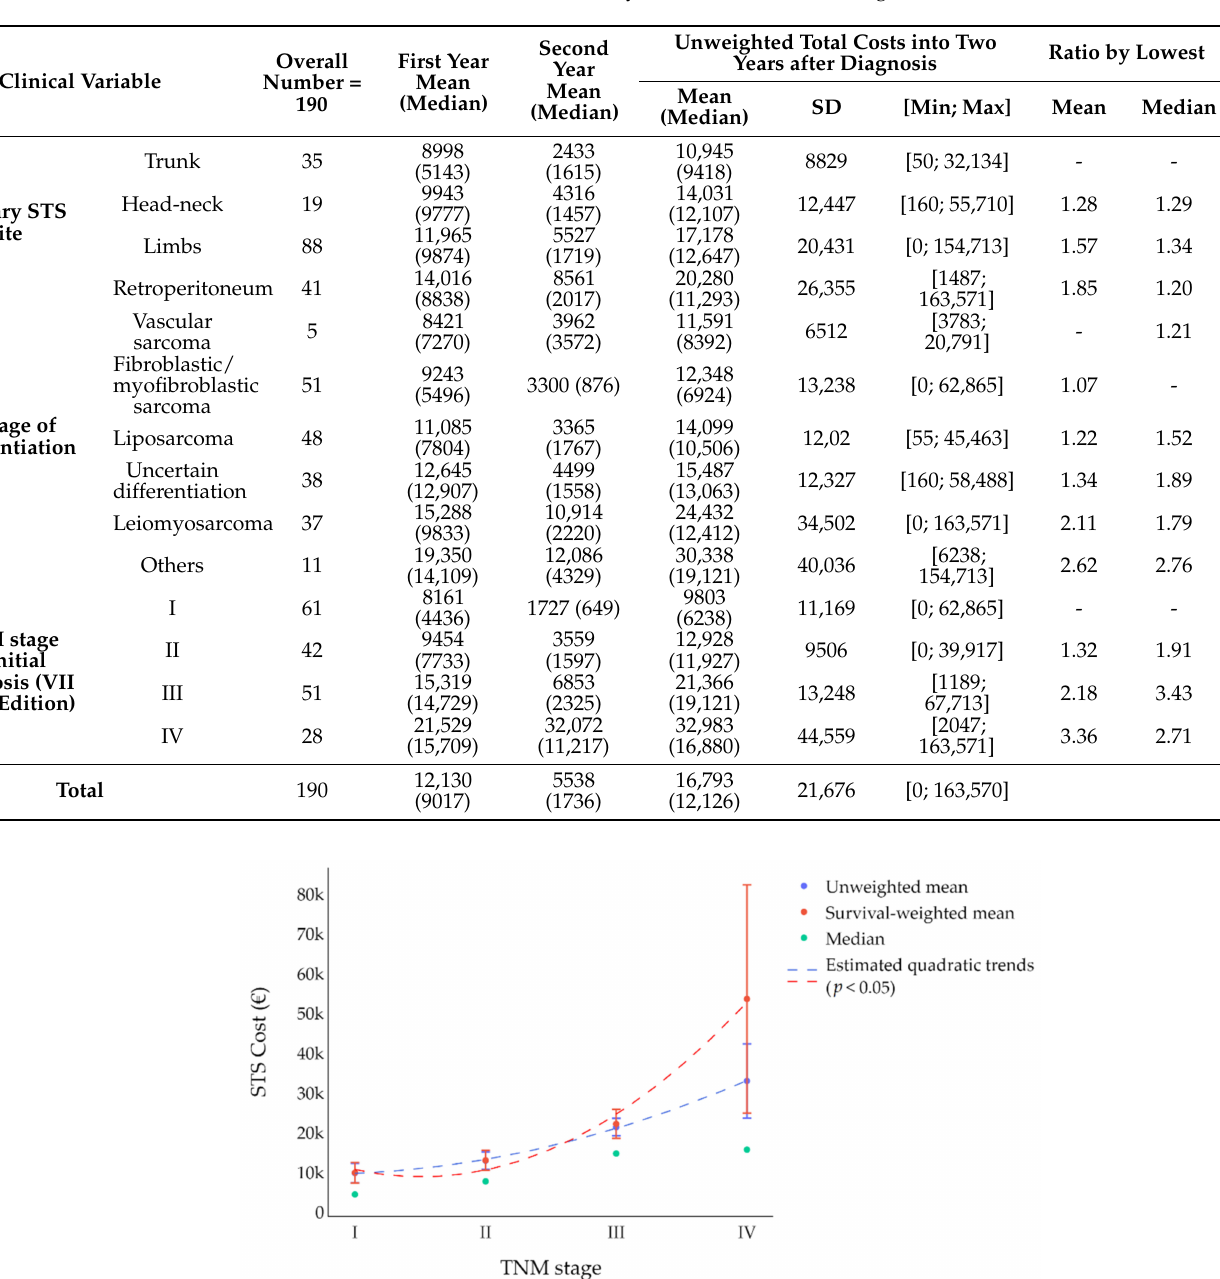
Table 2. Costs (in EUR) at first, second year and survival- unweighted total costs.